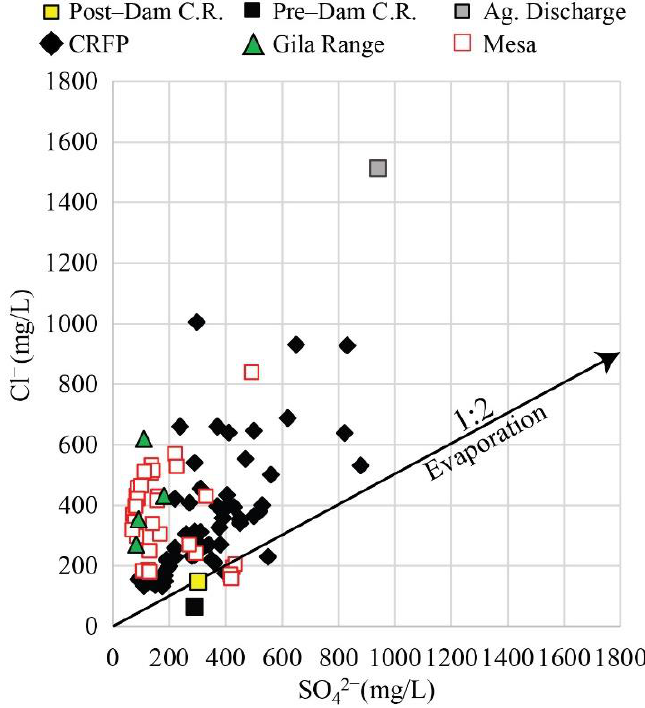
Figure 10. Cross-plot of Cl − and SO 42− concentrations (mg/L) for surface and groundwater in the study area. Arrow indicates hypothetical evaporation trajectory for Cl − /SO 42− = 1:2.